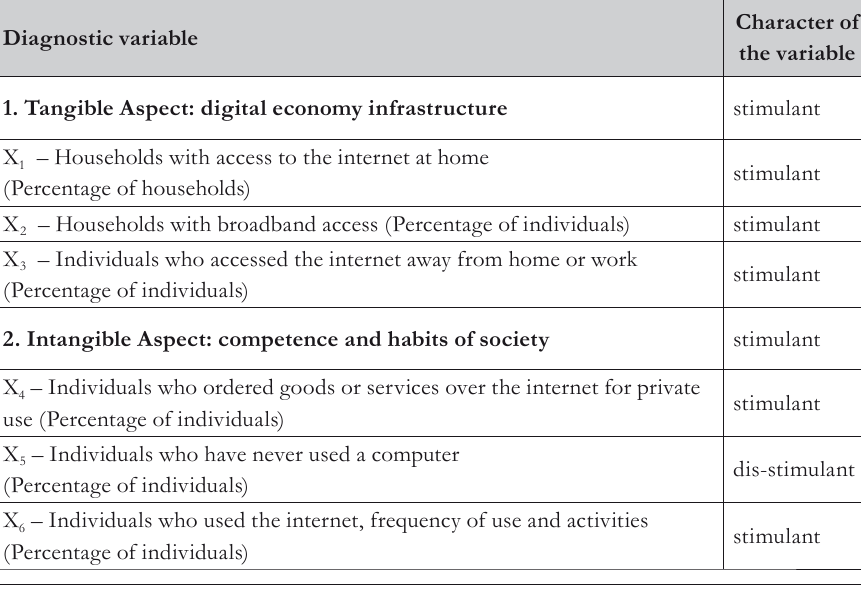
Tab. 1 – Diagnostic variables for digital economy. Source: Eurostat